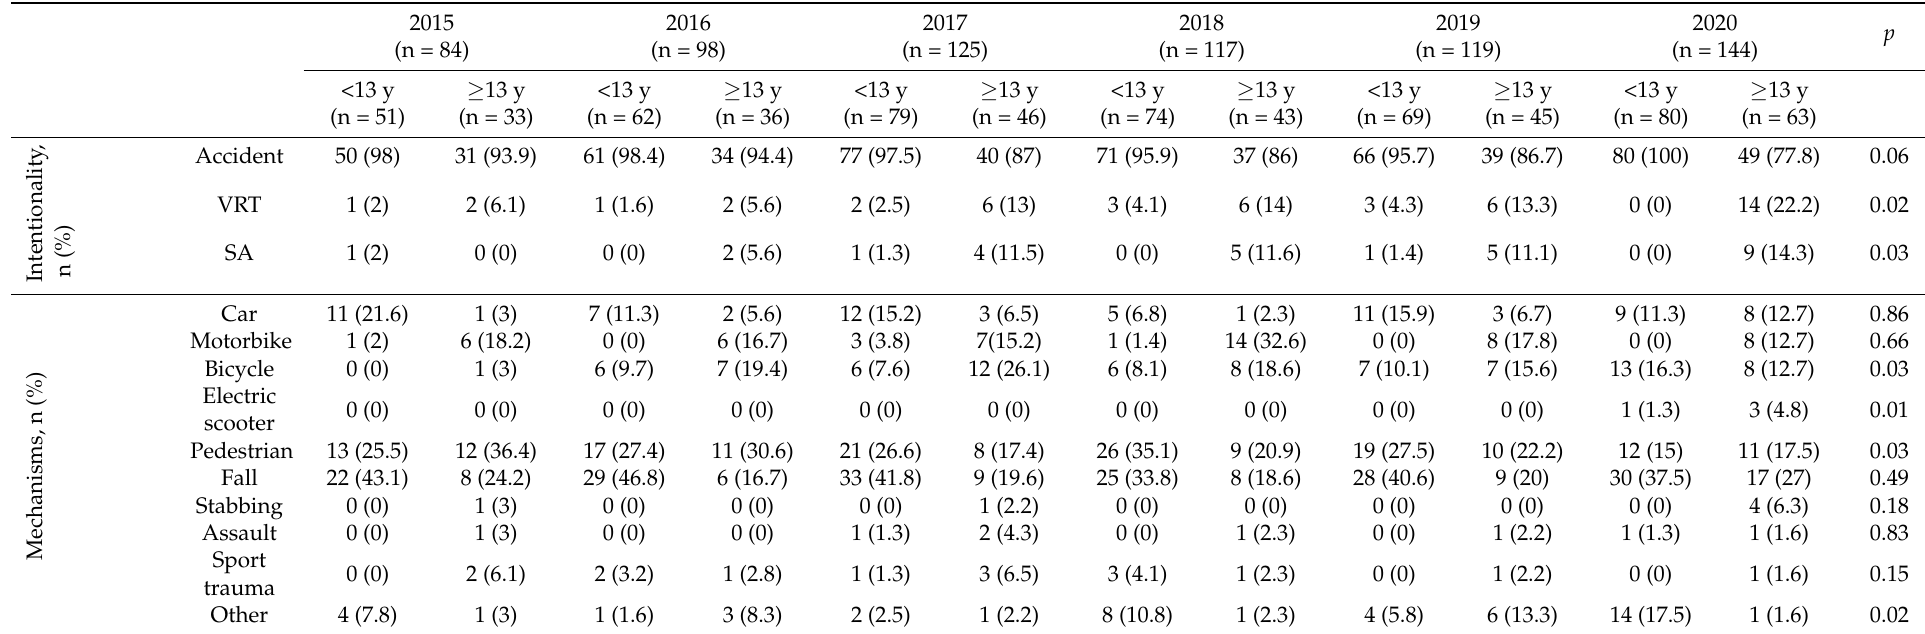
Table 4. Ages 0–12 y vs. 13–18 y: trauma intentionality and mechanisms over